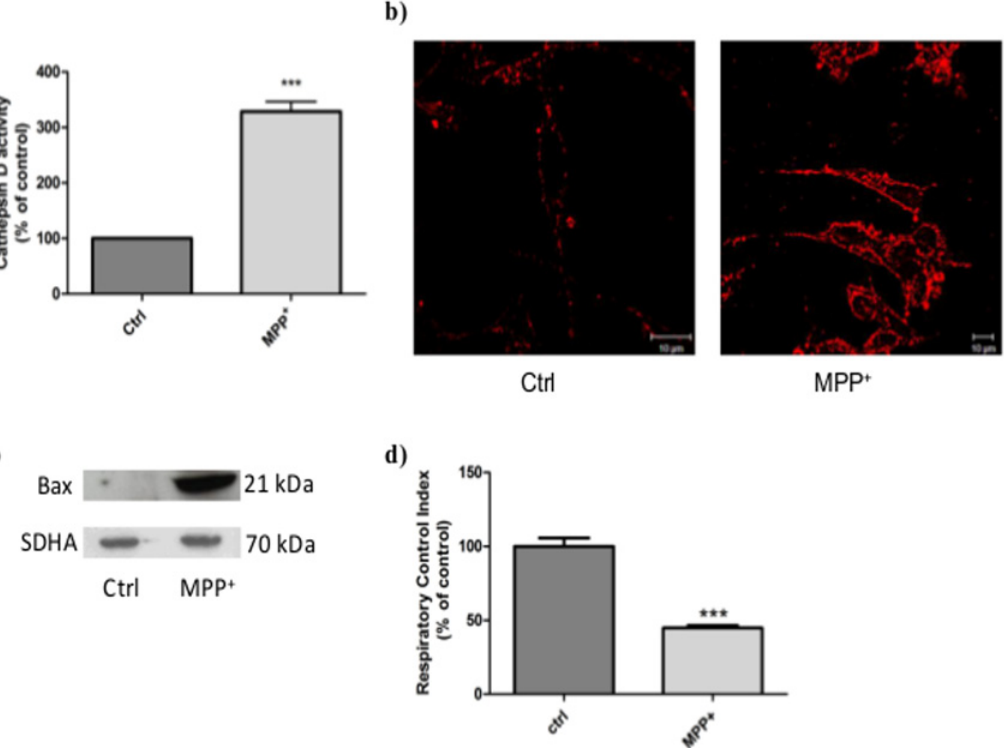
Figure 2. Characterization of MPP + -induced apoptosis. Total, mitochondrial and cytosolic extracts were obtained from normal and MPP + -stressed SHSY5Y cells (0.5 mM, 6 h).a) CathD activity in cytosolic extracts. CathD activity was normalized by cell number in each sample and expressed as percentage of the activity in normal cells. Results are expressed in percentage of normal cell extract levels and presented as mean ± S.E.M. of four independent experiments in triplicate. *** p < 0.01 compared to control cells. b) Immunofluorescence detection of total cathD in cells. Left: unstressed control cells (Ctrl), right: MPP + -stressed cells (6 h). Cells were observed with a confocal microscope Zeiss Axio Observer Z.1. Scale bar represents 10 μ m. Negative control omitting the first antibody but in the presence of the second one (anti-goat Fluo 546) did not show any signal. c) Analysis by western blot of Bax relocation in mitochondrial membranes at 6 h, just after the end of stress. The amount of protein was normalized by the number of cells to avoid taking into account the increase of protein amount induced by the MPP + stress. Succinate dehydrogenase-A (SDHA) was used as the loading control. This immunoblot is representative of three independent experiments in duplicate. d) Assessment of respiratory chain function 24 h after MPP + treatment. The respiratory control index (RCI) i.e. ratio [state 3 rate] / [state 4 rate] was calculated. Results are expressed as percentage of unstressed control group and represent three independent experiments in triplicate. Results are presented as the mean ± S.E.M. *** p < 0.01 compared to control